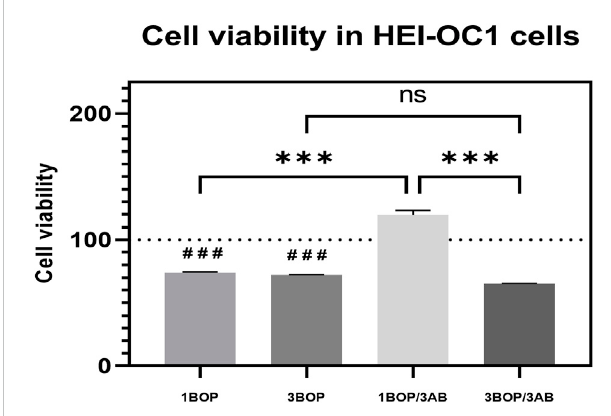
The histogram show the cell viability using CCK8 assay in HEI-OC1 cells following BOP/3AB treatment (3 mM). *** p < 0.001 among groups; ### p < 0.001 versus sham group. Values are represented as Mean ± SEM ( n = 3).